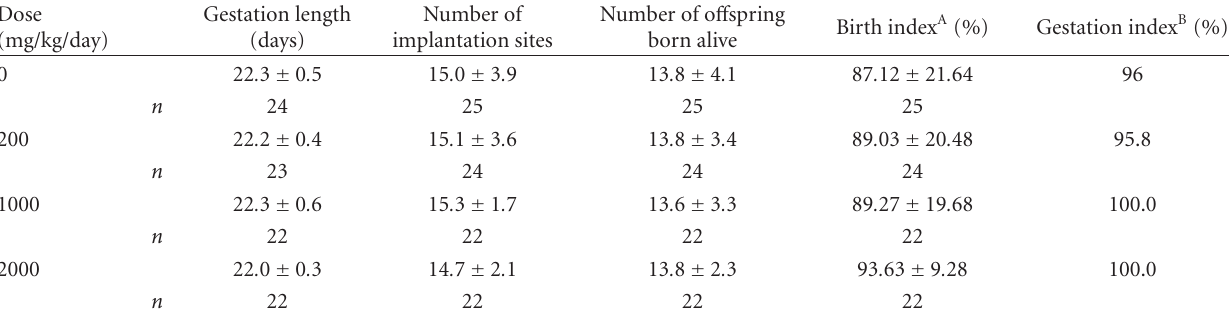
Table 7: E ff ects of SE5-OH administration on F 0 generation rat dam gestation and delivery parameters.